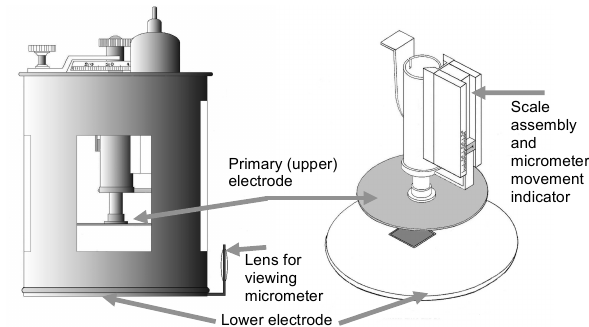
Figure 5. Simplified diagram of the Kelvin portable electrometer, showing outer casing (left) and (right) major internal components. Figure 4. (left) Photograph of the portable electrometer, courtesy of Glasgow University Library (right) technical drawing, taken from Thomson (1872).